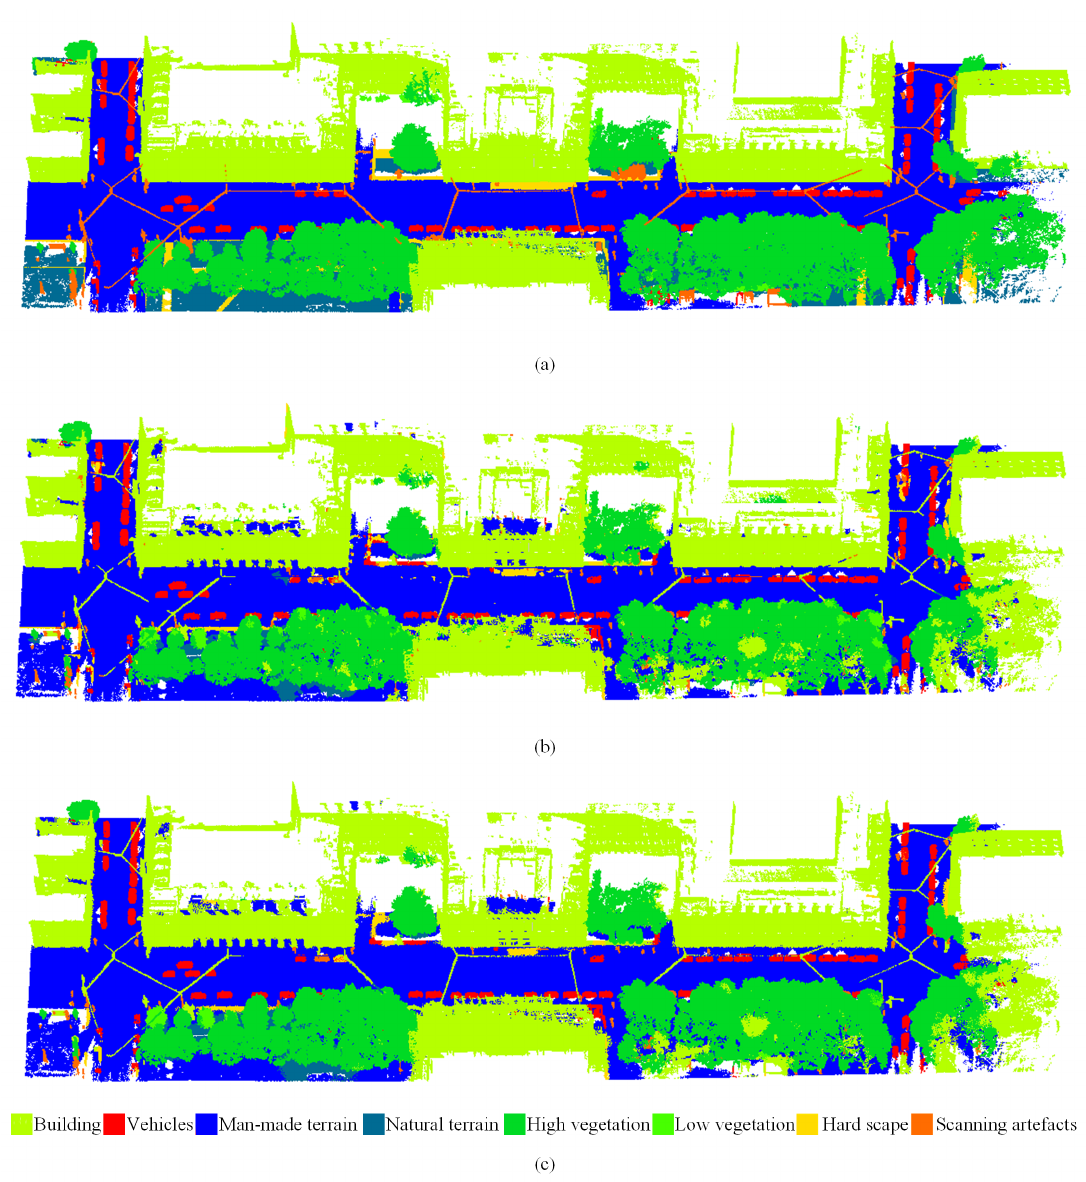
Figure 4. Illustration of the classification results on the TUM dataset. (a) benchmark with manual labels. (b) the classification results with PointNet++. (c) the optimized classification results with our proposed